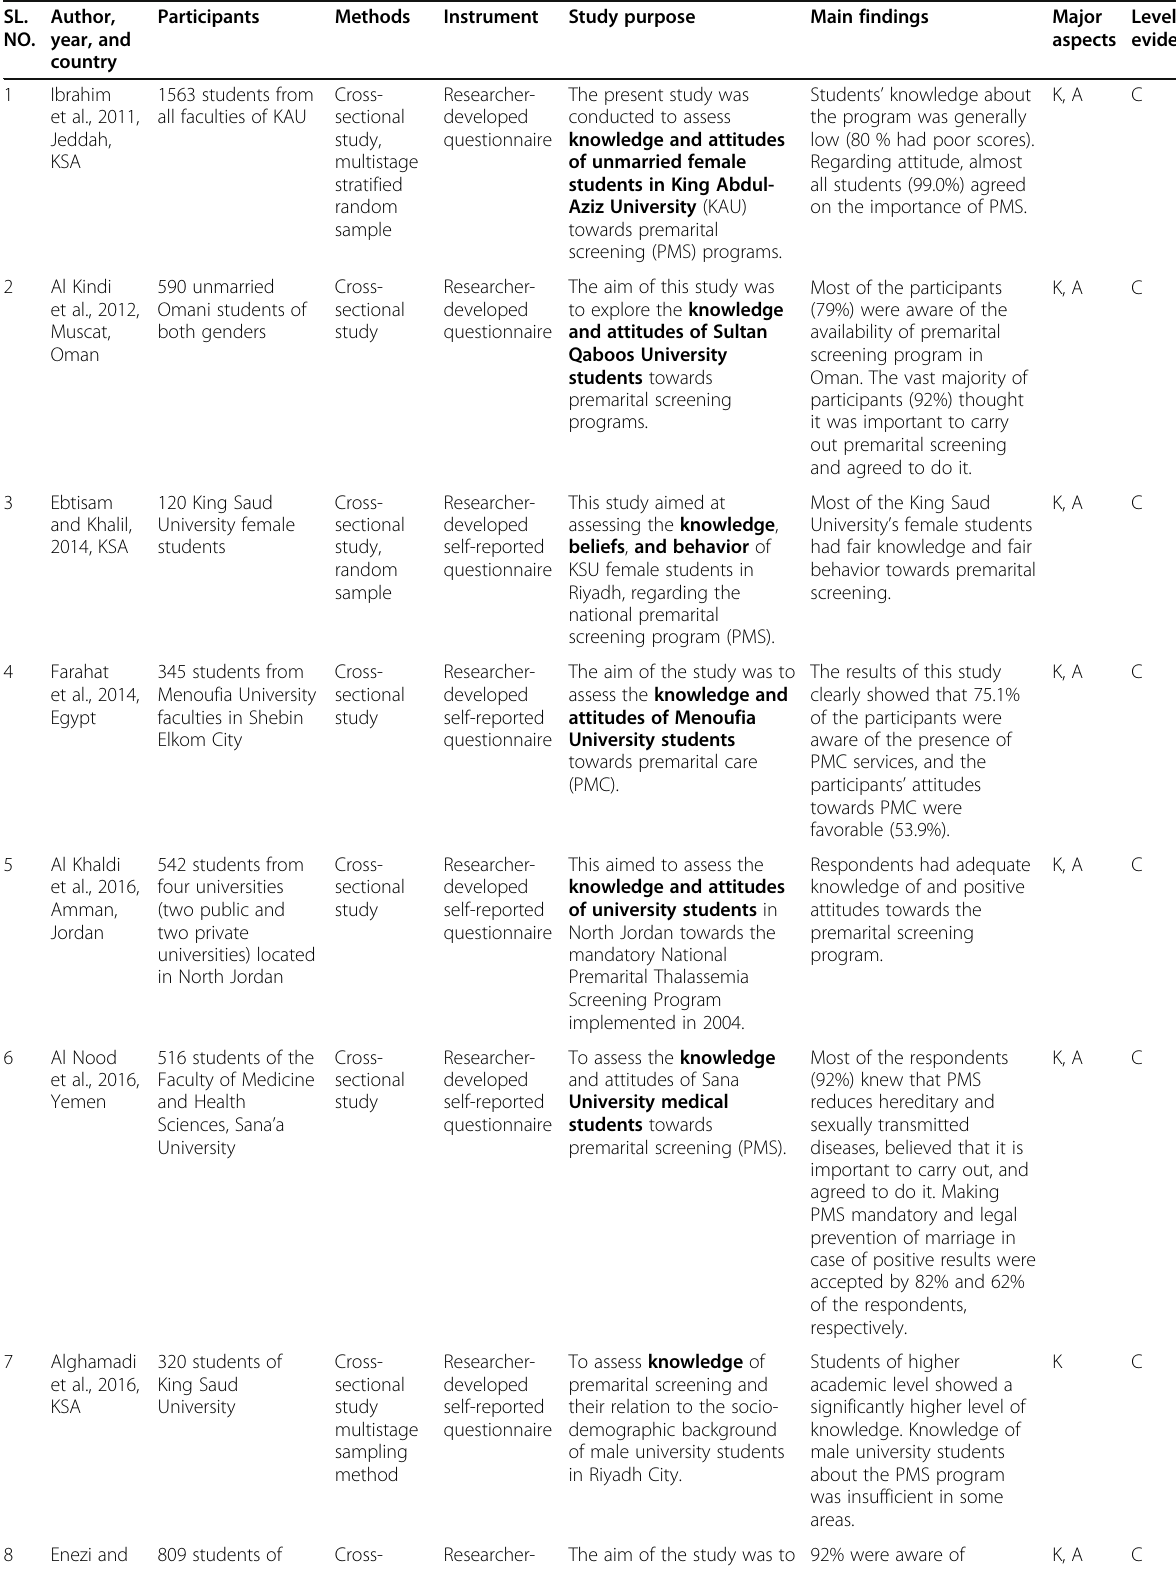
Table 1 Summary of the articles with author, country, year, participants, methods, instruments, study purpose, and main findings SL. Author, NO. year,